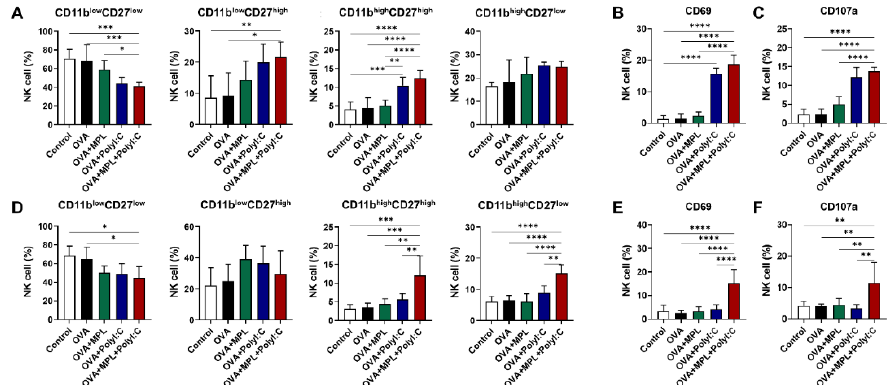
Figure 2. NK cell differentiation and activation marker expressions in lung after intranasal immunizations of OVA with adjuvants. Lung samples were harvested at day 1 post prime and boost vaccinations. ( A – C ) NK cell subsets and activation marker expressions after the prime immunization. ( D – F ) NK cell subsets and activation marker expressions after the boost immunization. The results show the mean ± SD. Statistical analysis between groups were performed by One-way ANOVA and Tukey’s multiple comparison test. *; p < 0.0332, **; p < 0.0021, ***; p < 0.0002 and ****; p <